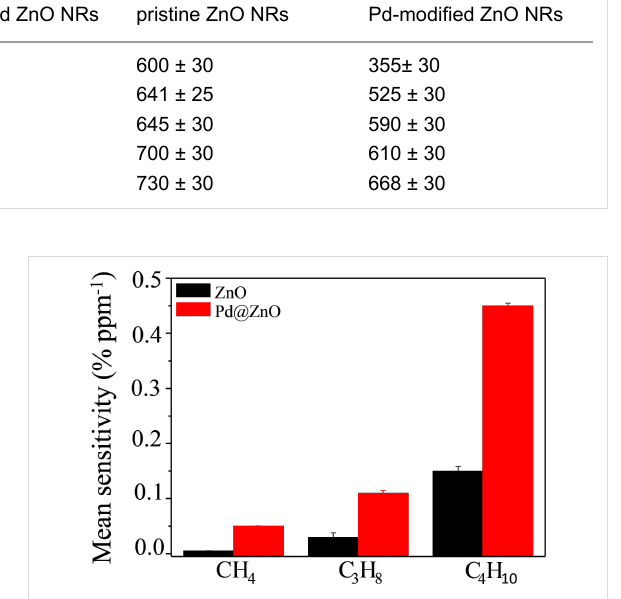
Table 2: Comparison of the response time (t Response ) and recovery time (t Recovery ) between pristine and Pd-modified ZnO NRs at various C 4 H 10 con- centrations. t response (s) t recovery (s)